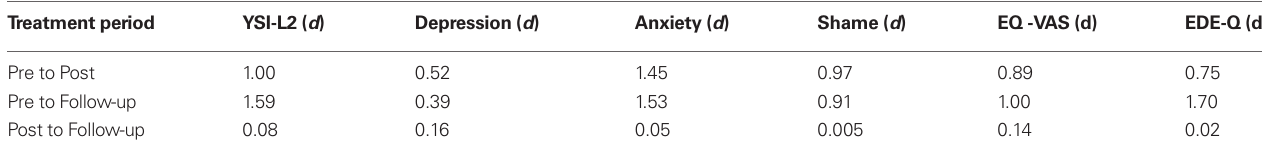
Table 3 | Effect size ( d ) scores for all six questionnaire measures, showing both pre to post effects and pre to follow-up